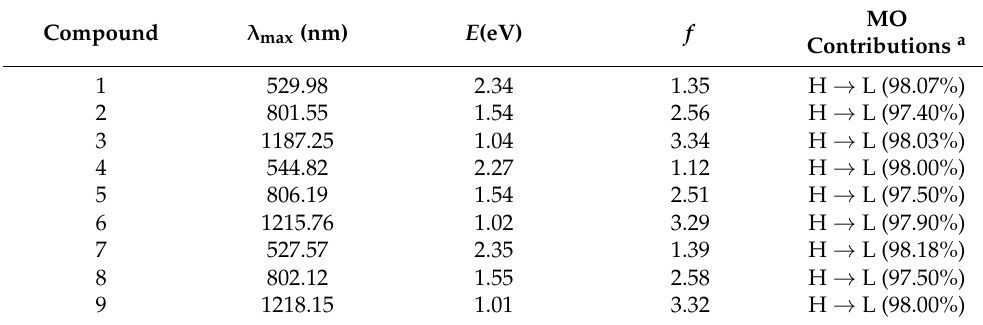
Figure 8. The UV − vis spectra of the nine compounds. Table 3. Excitation energy ( E ), oscillator strengths ( f ), wavelengths ( λ max ), and MO contributions of the